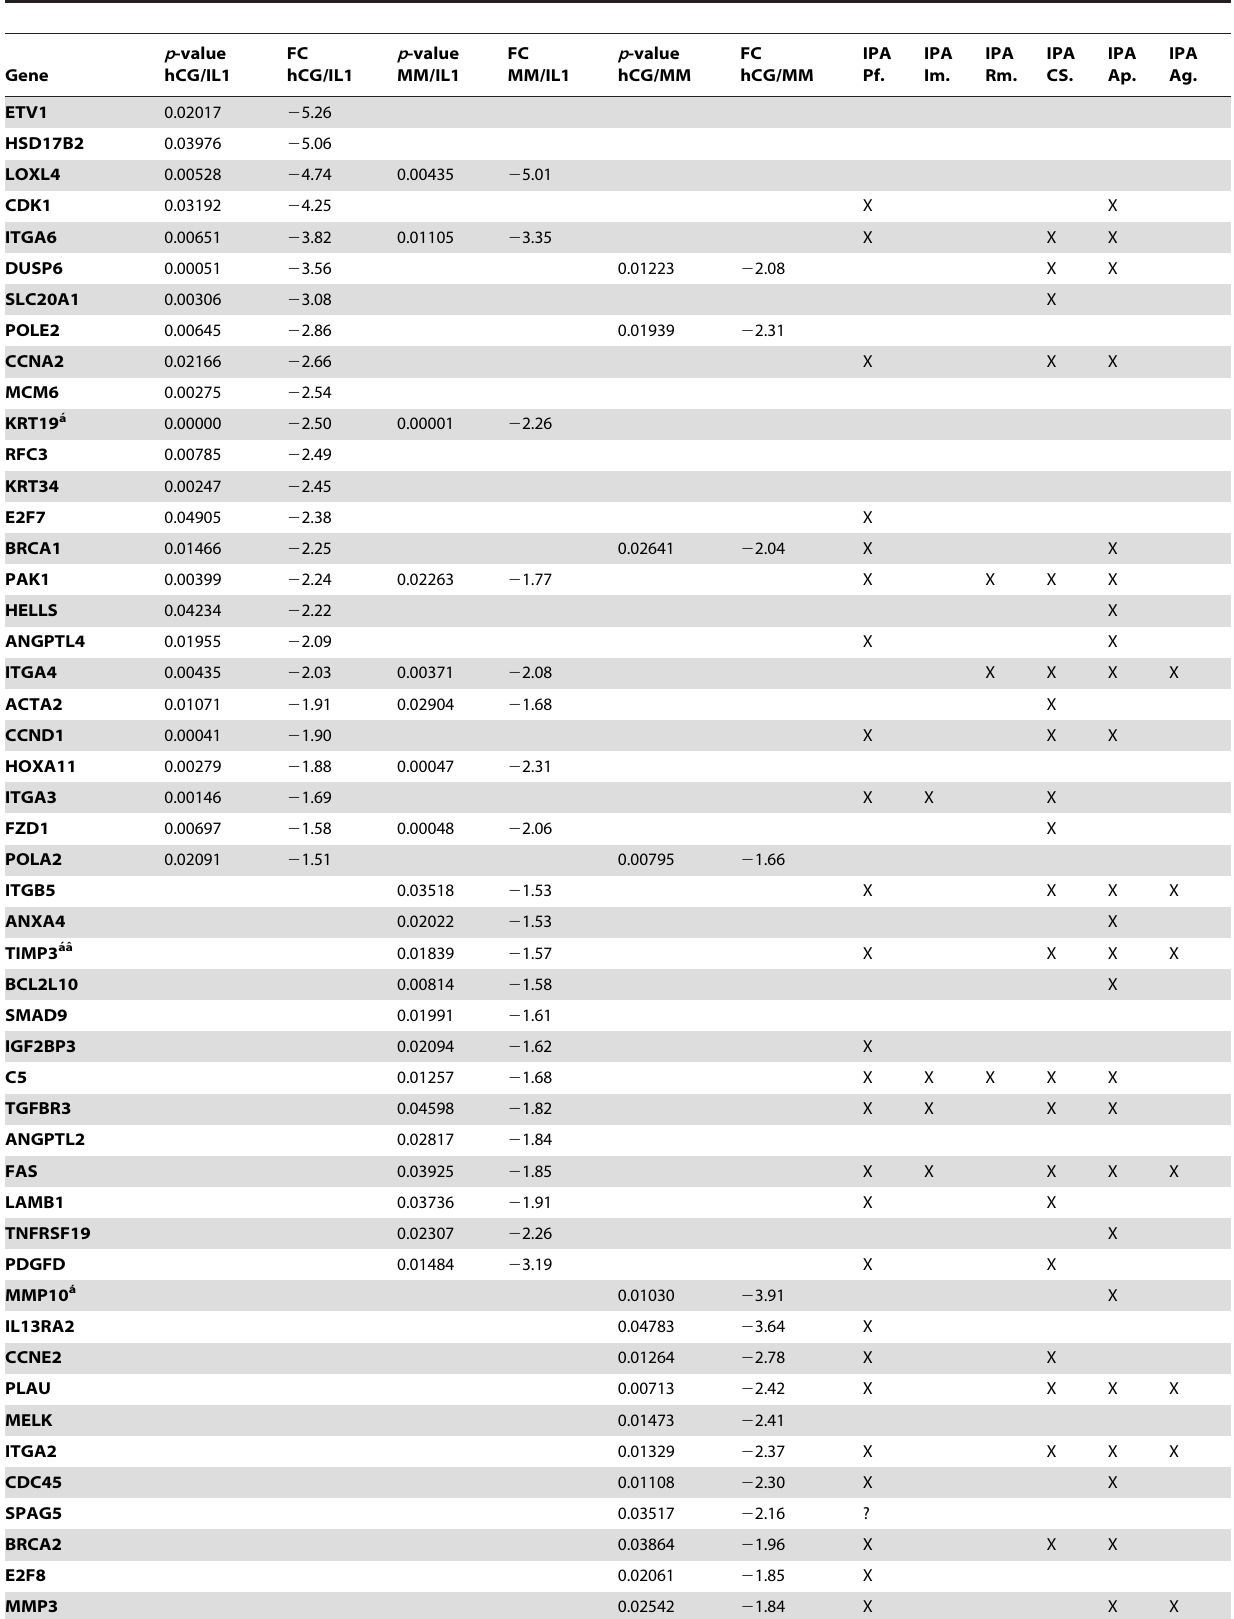
Table 4. Genes down-regulated after in vitro treatment of human endometrium stromal cells.